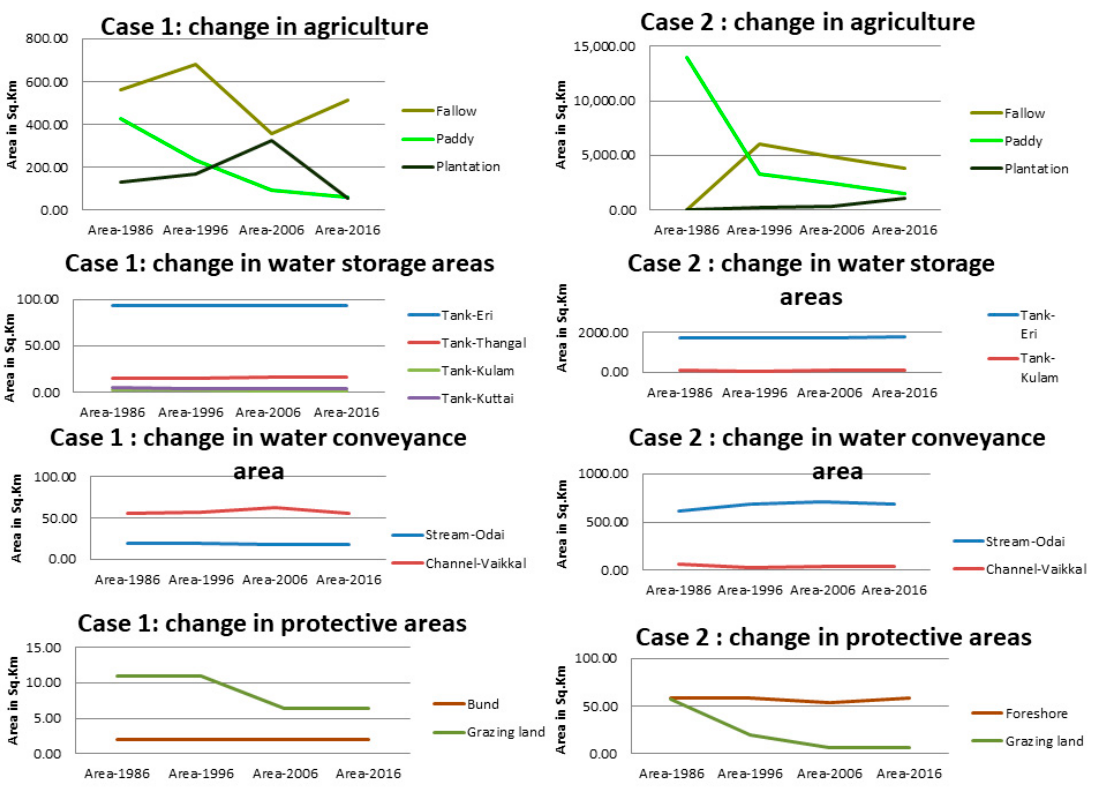
Figure 6. Trends in land use change components within agricultural land and common land for case 1 and case